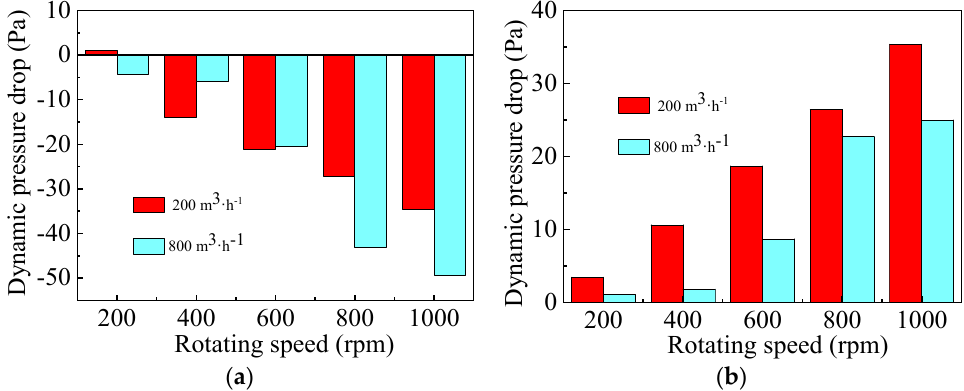
Figure 9. The dynamic pressure drop in the packing zone. ( a ) Plane a 3 to a 4 ; ( b ) plane a 4 to a 5 .